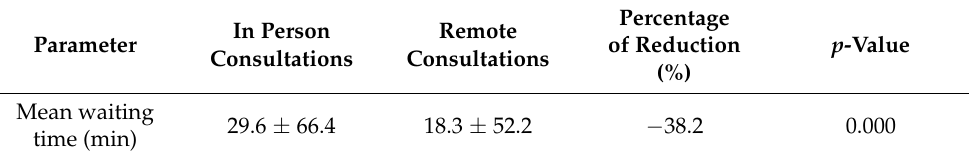
Table 3. Statistical comparison between the in person and remote consultation after the Lean inter-